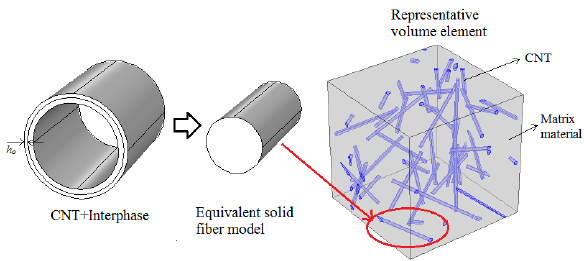
Fig. 1: Multiscale modeling procedure to form the representative volume element reinforced by equivalent solid fibers (ESF) made of CNT and interphase